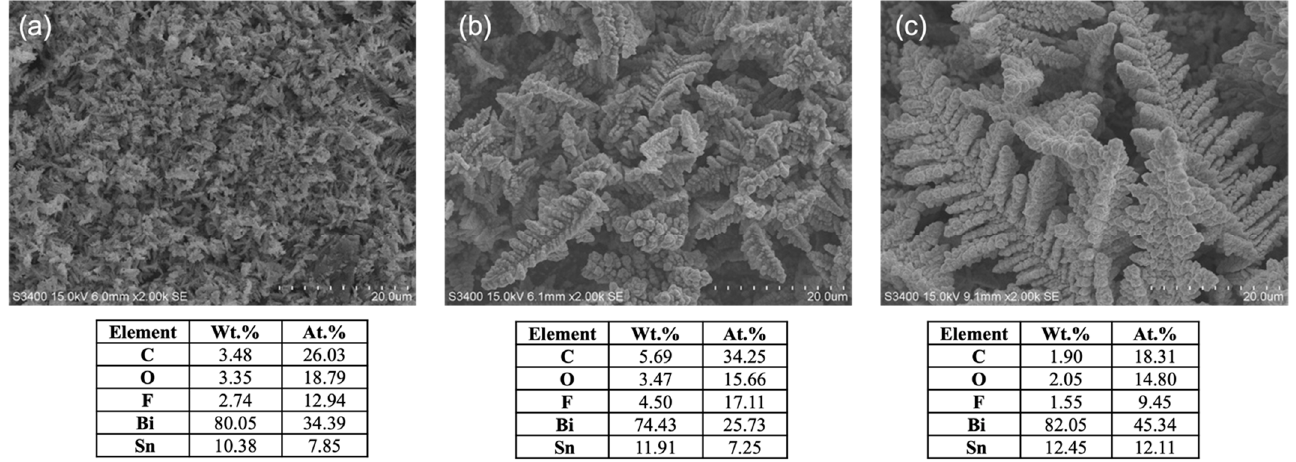
Figure 6. SEM-EDX results of ( a ) 0.01Bi/Sn, ( b ) 0.05Bi/Sn, and ( c ) 0.1Bi/Sn electrodes after CO 2 RR at − 1.1 V vs. Ag/AgCl . at − 1.1 V vs.